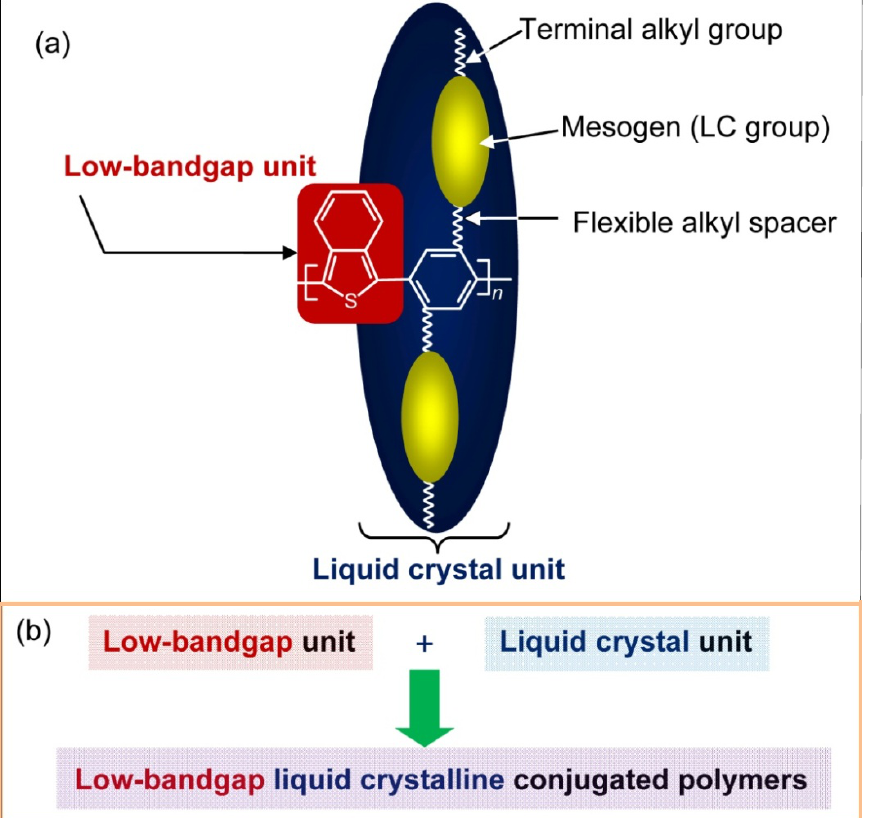
Figure 1. ( a ) Molecular structure of low-bandgap liquid crystalline conjugated polymer; ( b ) A concept of low-bandgap liquid crystalline conjugated